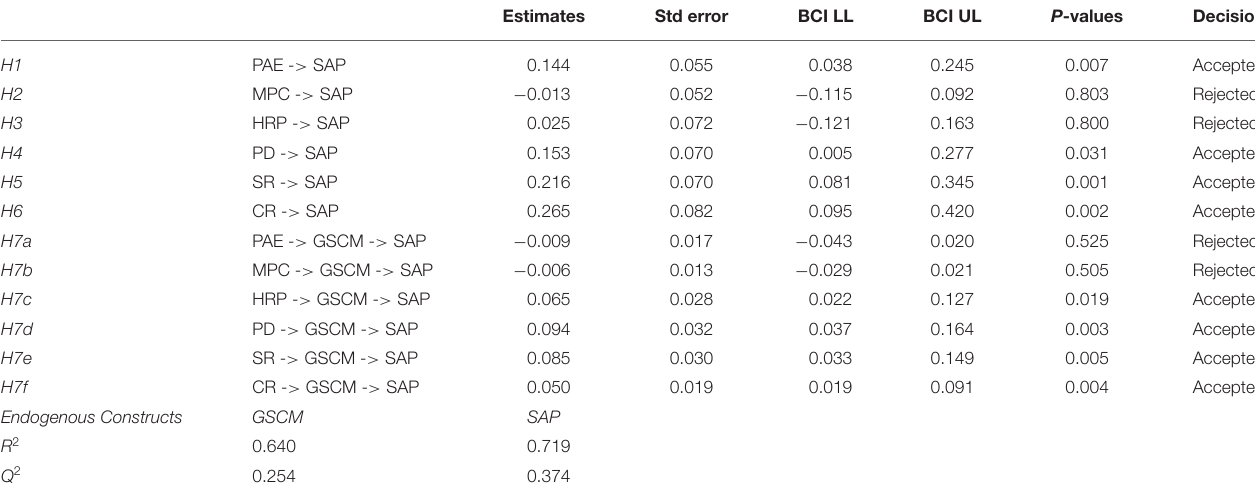
TABLE 4 | Hypotheses testing